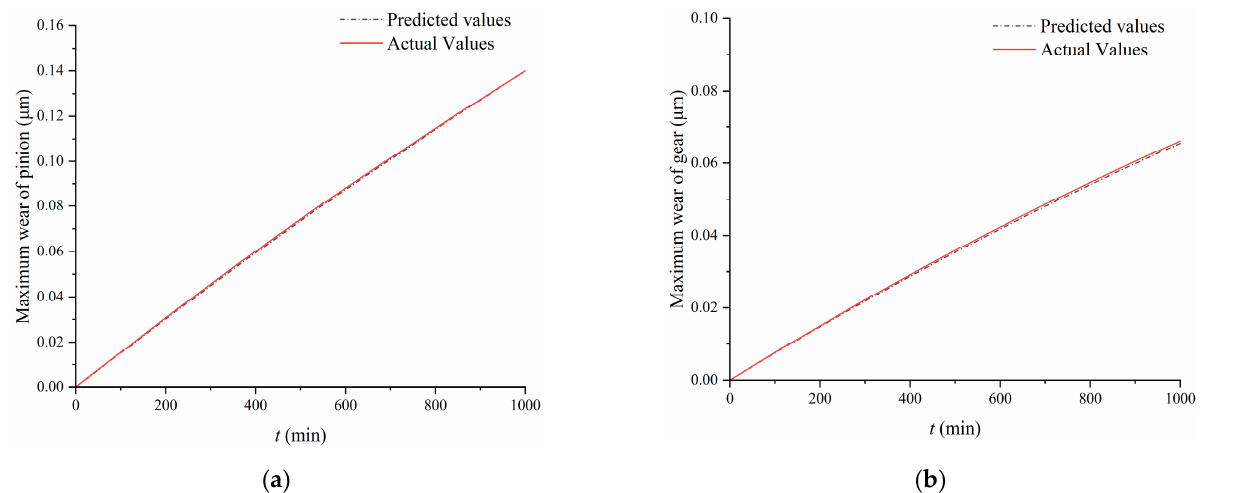
Figure 7. Calculation accuracy of the Kriging model: ( a ) Pinion; ( b ) Gear.